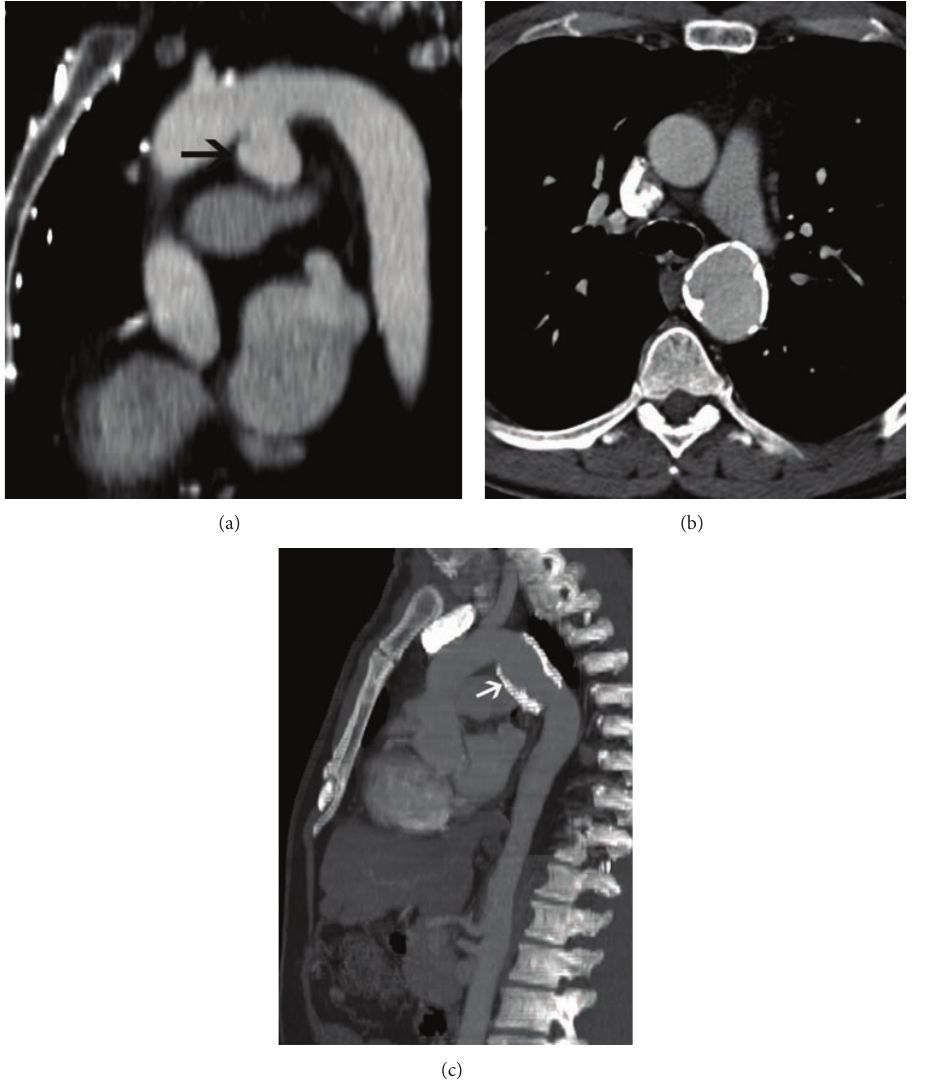
Figure 11: Chronic traumatic aneurysm—(a) sagittal reconstructed CT image in a 71-year-old male involved in road traffic accident five years back shows a saccular pseudoaneurysm in the aortic isthmus. (b) Axial CT image in a 65-year-old male involved in motor vehicle accident ten years back shows a calcified aneurysm of the aortic isthmus. (c) Sagittal reconstructed CT image in a 65-year-old male involved in motor vehicle accident ten years back shows a calcified saccular pseudoaneurysm in the aortic